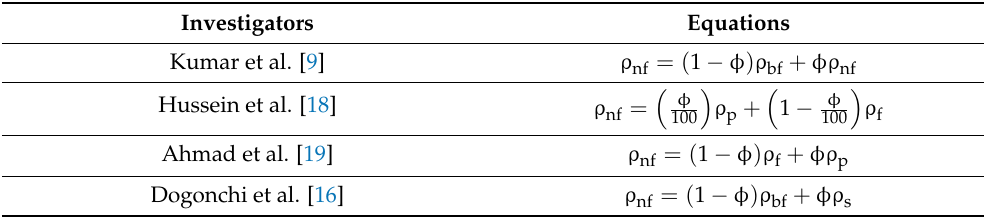
Table 2. Equations used for calculating the density of nanofluids.